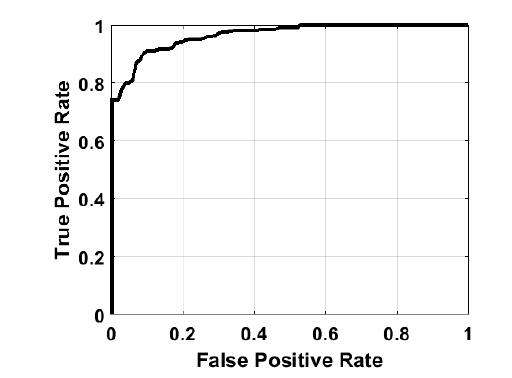
Figure 13. The indoor signal propagation